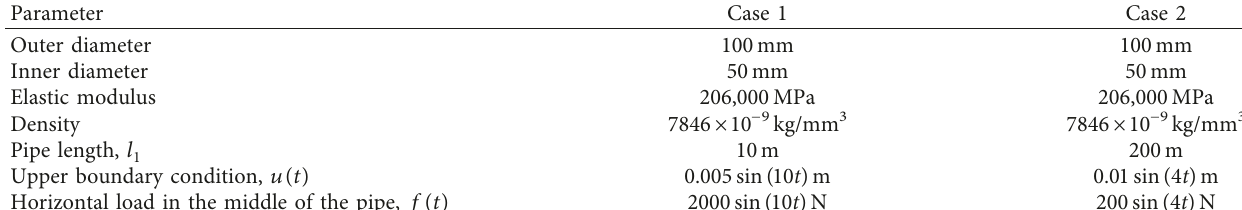
Table 1: Parameters of the